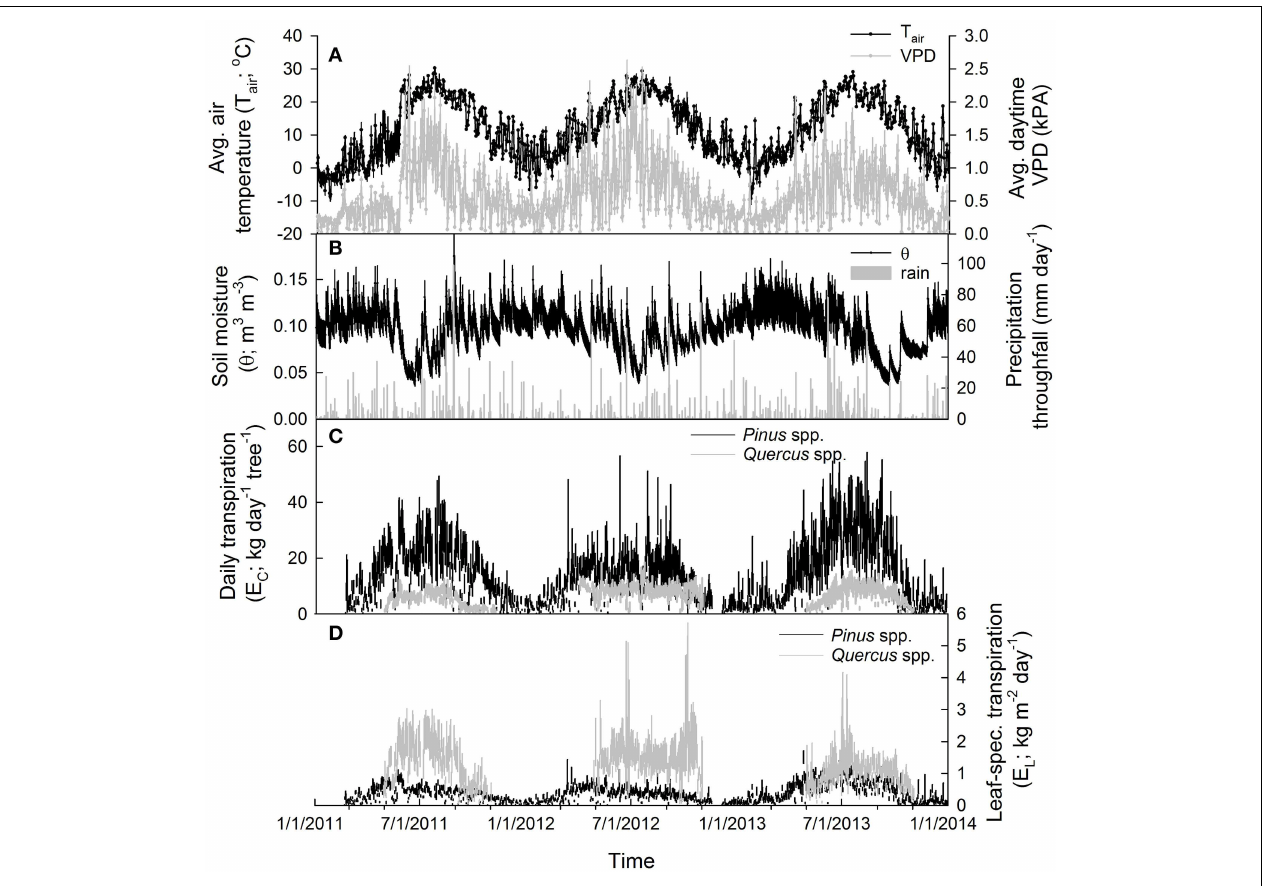
throughfall (mm day − 1 ). (C) Total daily tree-level transpiration (E C ; kg day − 1 ; mean ± SE of all individuals in each site/species category) for oaks and pines and (D) total daily leaf-specific transpiration (E L ;kg m − 2 − 1 ; mean ± SE of all individuals in each site/species leaf area day category) for oaks and